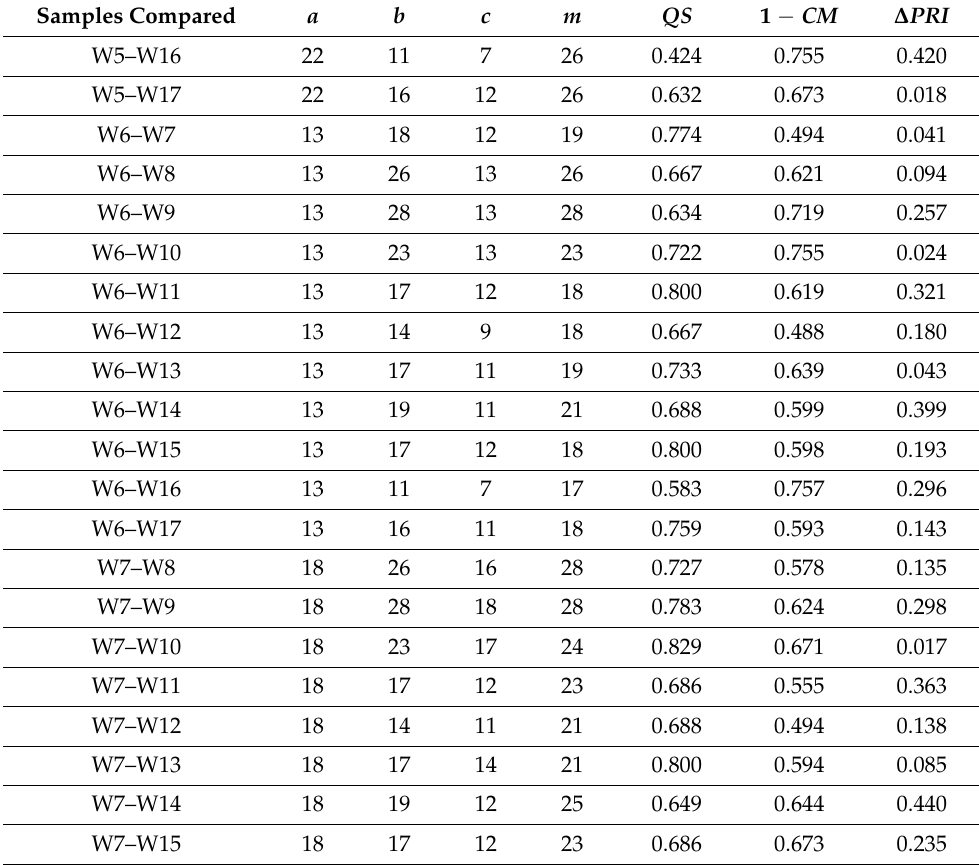
Table A3. Data supporting the case study